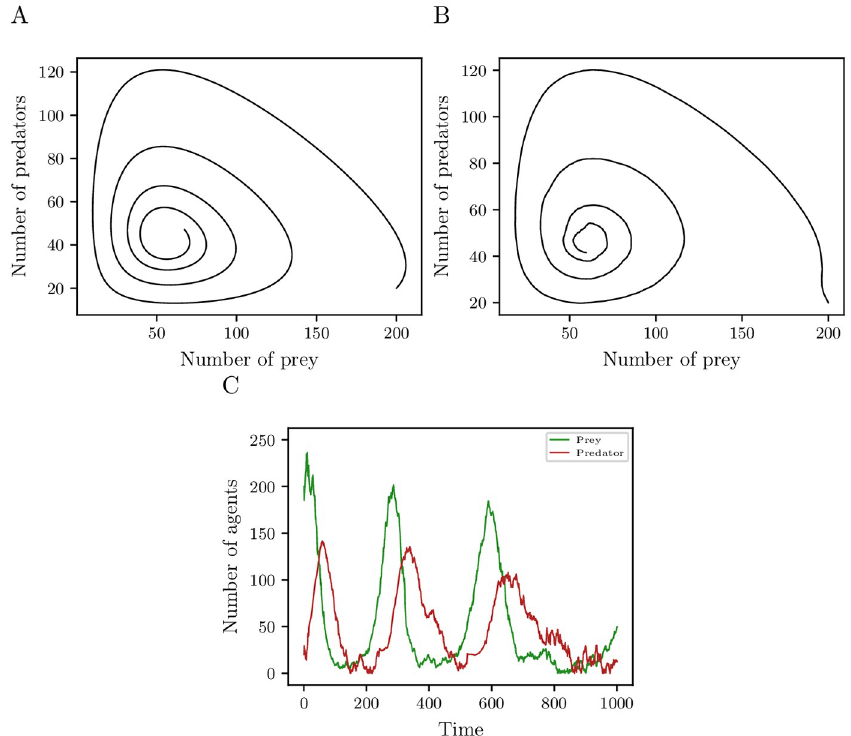
Fig 8. Prediction of predator-prey model. Phase portraits of first-order moment of (A) the reduced SDE model and (B) the PPM estimated from 958 Monte Carlo simulations. (C) Realization of the reduced SDE solution learned from m = k = 1000 measurements and samples for the PPM with parameters given in Table